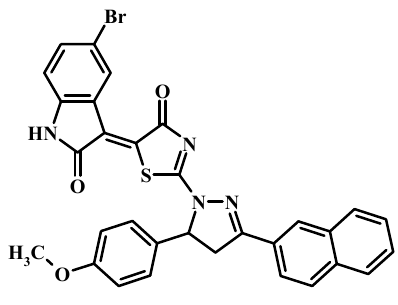
Figure 1. Structure of the investigated Les ‐ 3833 compound.